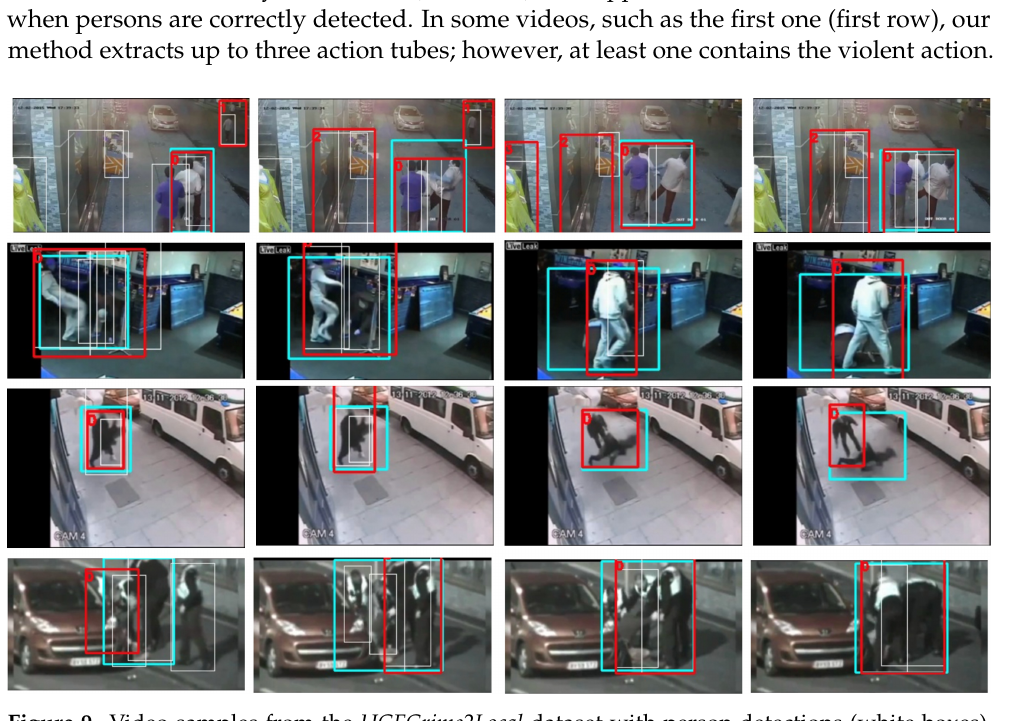
Figure 9. Video samples from the UCFCrime2Local dataset with person detections (white boxes), ground truth (light blue boxes), and action tubes (red